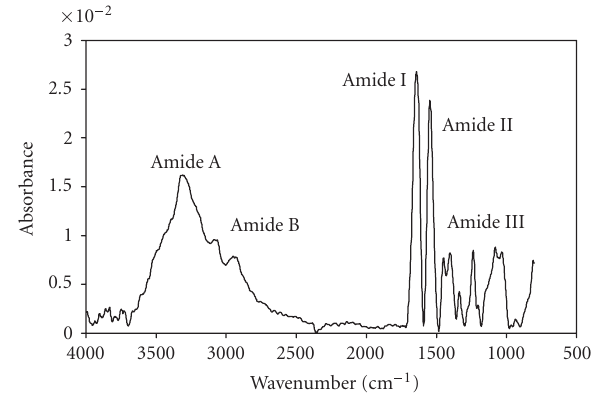
Figure 3: FTIR spectra of a collagen film. The Amide A, B, I, and II bands appear shifted to lower wavenumbers after solar irradiation.